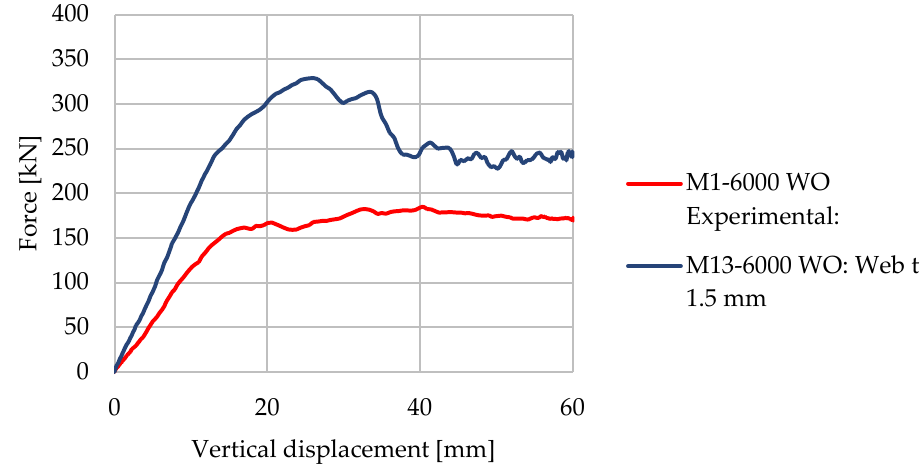
Figure 25. Force–displacement curves for the beam with a web opening, a length of 6000 mm, and corrugated webs with different thickness.